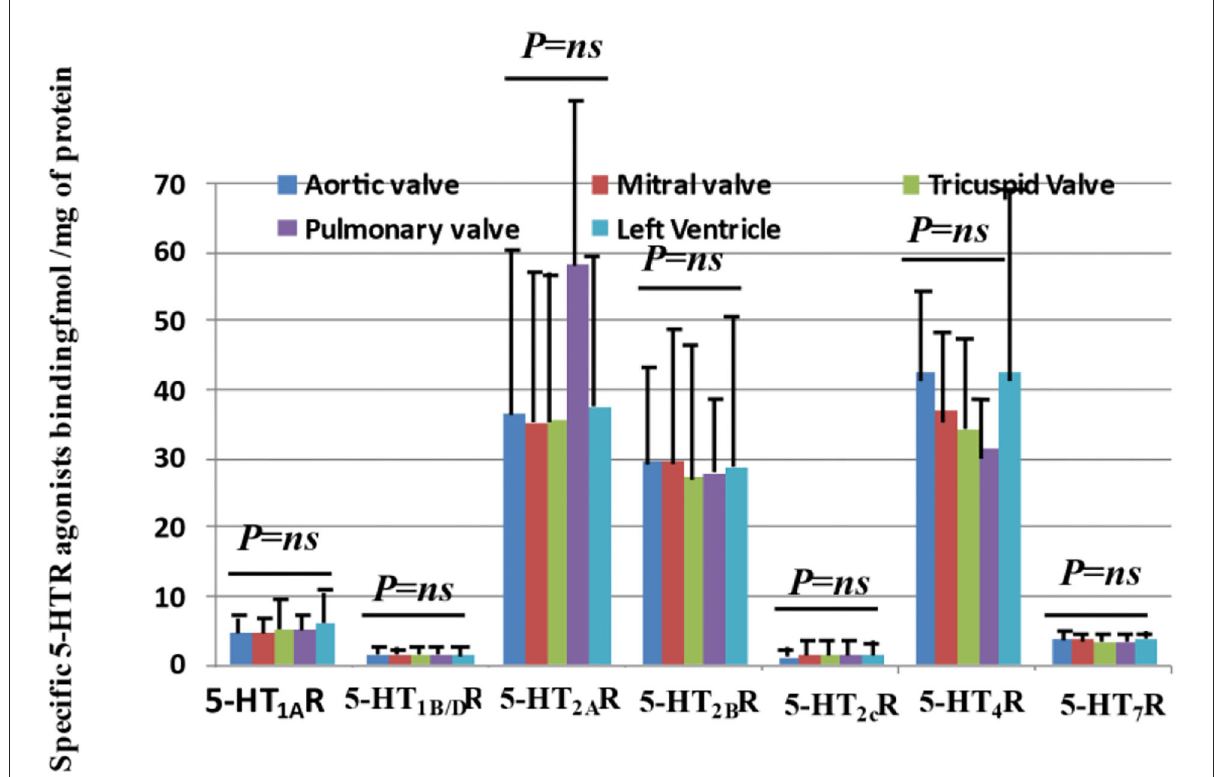
FIGURE1 Quantitative expressions of 5-HTR receptors on human “normal” heart valves by radioligand binding affinity with the human left ventricle (i.e., diseased left cardiomyopathy) as a control. This figure shows the quantitative measurements of receptor expression for aortic, mitral, tricuspid, and pulmonary valves with the left ventricle as a control. Specific quantification of the protein expression for 5-HTRs (5-HT 1A R, 5-HT1 B / D R, 5-HT 2A R, 5-HT 2B R, 5-HT 2C R, 5-HT 4 R, and 5-HT 7 R) on valvular tissue protein extract was performed with specific radioligands. 5-HT 1A R and 5-HT 1B / D R are known to be associated with a Gi/Go protein and thus decrease cAMP levels. On the other hand, 5-HT 4 R and 5-HT 7 R are associated with a Gs protein and thus increase cAMP levels. 5-HT 2 Rs are associated with another G-type protein (Gq/G 11 ) and thus activate PLC, Src, and Ras. 5-HTR 7 R was the most recent receptor to be identified. Up until now, no quantification of 5-HTRs has been conducted on human heart valves. We had access to a total of 28 transplant hearts and had mitral and tricuspid sites for all of them. For 14 hearts, we had the three main sites (aortic/mitral/tricuspid), and for three hearts, we had four sites at the same time (including pulmonary site). All measurements of expression levels were performed in triplicate. As shown in this figure, all types of receptors we tested, known to be expressed in peripheral tissues, are expressed in valvular tissues, with the main receptors being quantitatively 5-HT 2A R, 5HT 2B R, and the unreported 5-HT 4 R. Interestingly, we did not observe any difference in terms of the level of expression between the different sides and sites investigated. Each bar diagram in the figure is based on 28 samples for tricuspid and mitral valves, with left ventricle as control, and 14 samples for the aortic position. P -values correspond to the results of ANOVA tests. No particular difference was observed between the right sides (i.e., tricuspid, pulmonary) and left sides (i.e., aortic, mitral) (ANOVA test). The pulmonary positions (i.e., only 3 samples available) tended to have the same level of expression as the other sites.